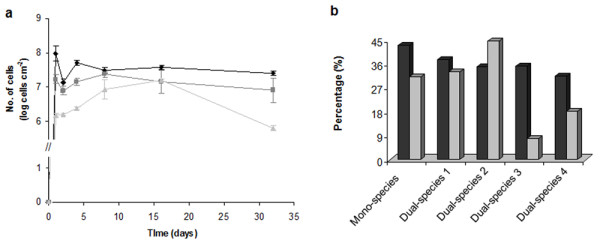
Numbers of L. pneumophila cells in mono and dual-species biofilms. Variation of the number of cells of L. pneumophila in mono-species biofilm quantified by the three different methods: curves represent the variation of total cell number (black diamond), L. pneumophila hybridized with the PNA PLPEN620 probe (dark grey square) and cultivable L. pneumophila (light grey triangle); bars represent standard deviation (n = 3) (a). L. pneumophila PNA-positive numbers/total cells numbers ratio (dark grey bars) and cultivable L. pneumophila numbers/L. pneumophila PNA-positive numbers ratio (light grey bars) for the mono-species biofilm and dual-species biofilms of L. pneumophila and V. paradoxus (Dual-species 1), L. pneumophila and M. chelonae (Dual-species 2), L. pneumophila and Acidovorax sp. (Dual-species 3) and L. pneumophila and Sphingomonas sp. (Dual-species 4); the ratio values were calculated using the average of the values obtained for the six time point samples (b).